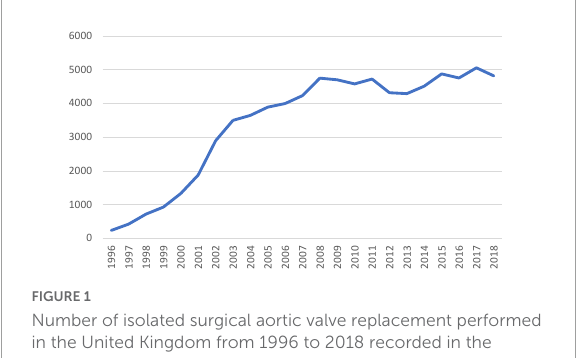
FIGURE1 Number of isolated surgical aortic valve replacement performed in the United Kingdom from 1996 to 2018 recorded in the national